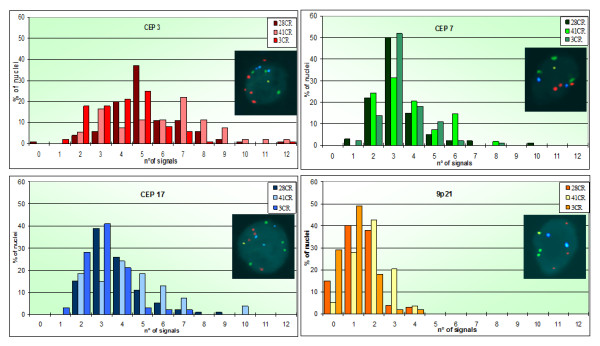
Urovysion signals distributions. Urovysion FISH with red (chromosome 3), green (chromosome 7), aqua (chromosome 17) and gold (locus 9p21) probes. Comparison of signals distributions in the three TURBs, with an example of the most representative cell.